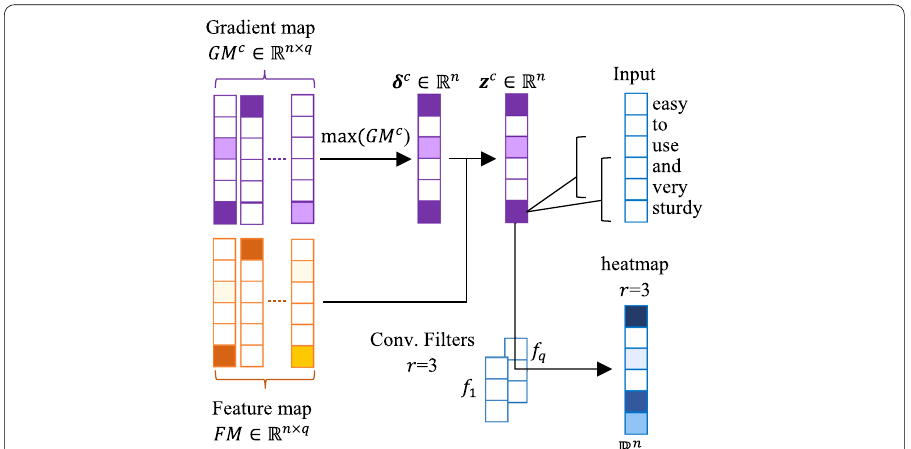
Fig. 2 Dataflow of the WGA() function used in Line 2 of Fig. 1; n , r , and q represent the number of words, the window size, and the number of filters,